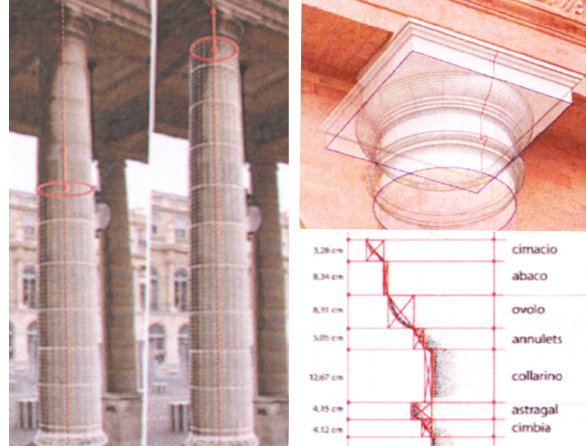
Figure 6. 3D modelling based on the interpretation of geometrical nature of architectural elements, Primitive adjusted on the point cloud (De Luca, L.)